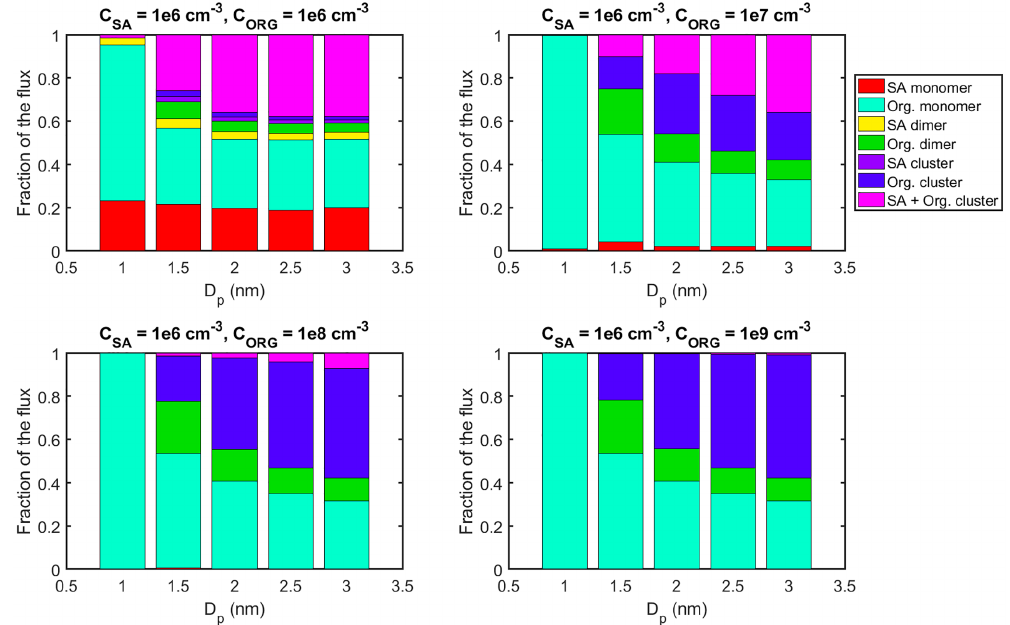
Figure 6. Contribution of different vapor monomers and clusters to the net flux past certain threshold sizes in simulations with SA–DMA